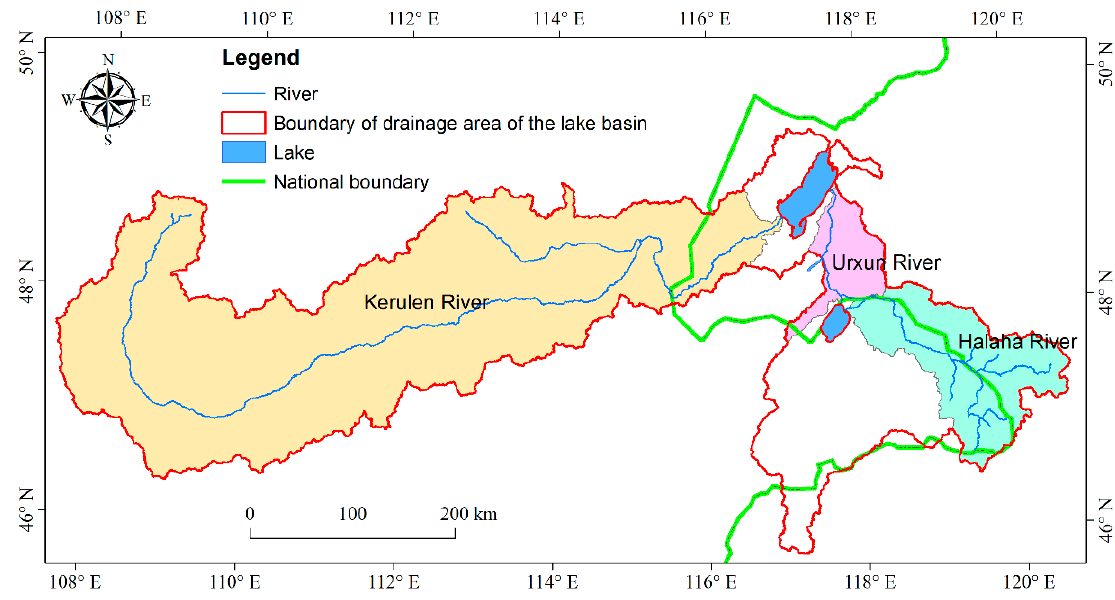
Figure 2. Distribution range of the drainage area of Hulun Lake.